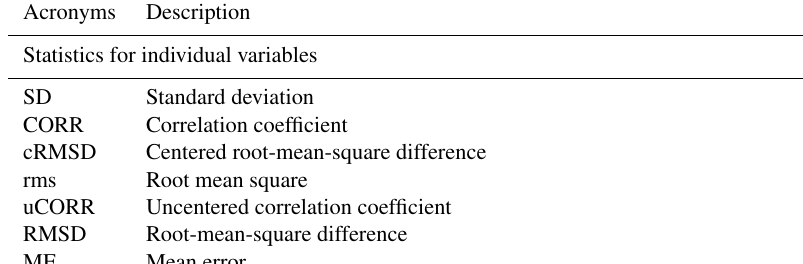
Table A1. Table of statistics in the improved multivariable integrated method with their acronyms and